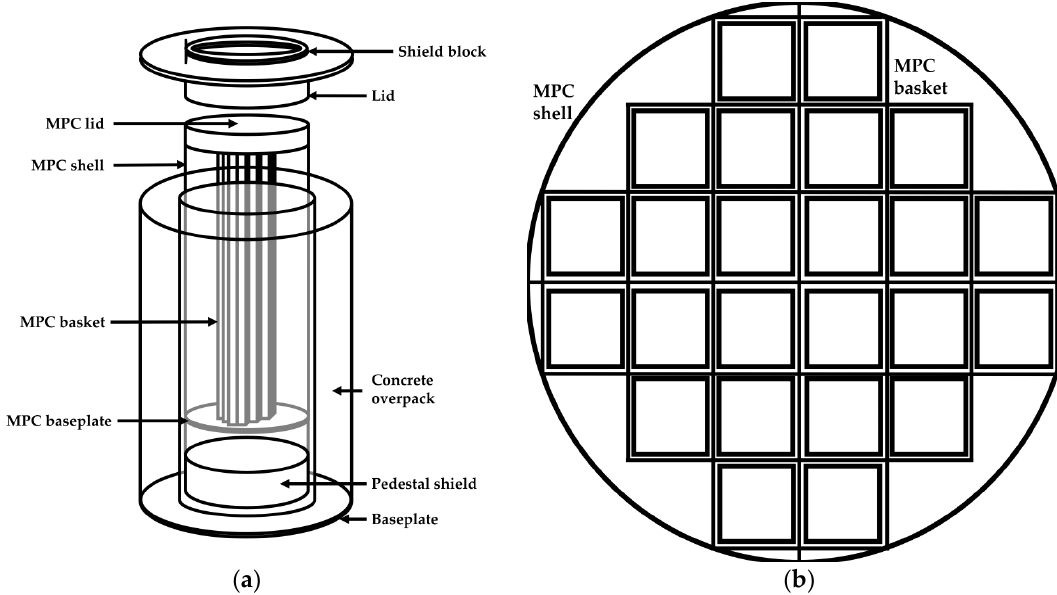
Figure 1. Conceptual view of the HI-STORM 100 DSS to store PWR SNF [16]: ( a ) concrete